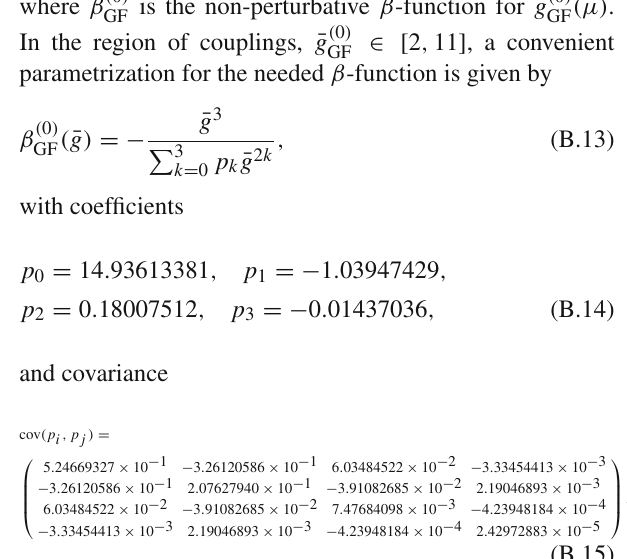
( 0 ) and ¯ g for c = 0 . GF GFT,c